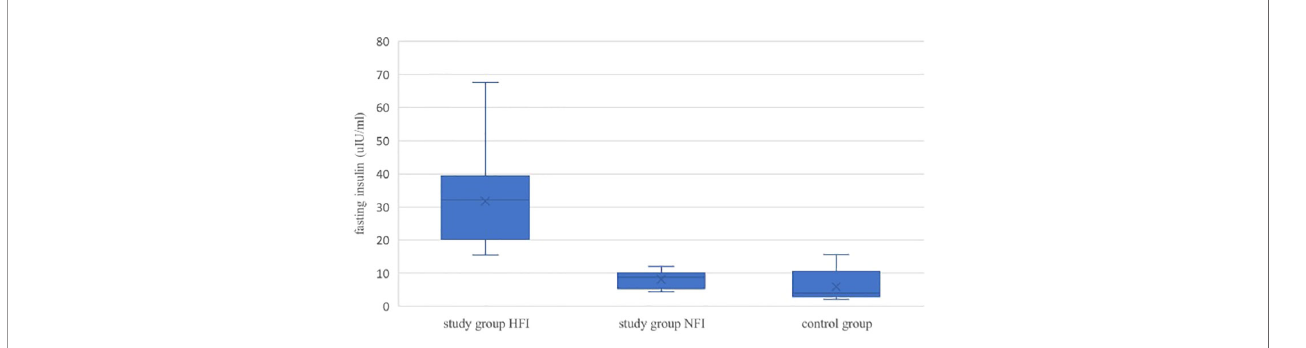
FIGURE 4 | Comparison of fasting insulin concentration in overweight/obese children and controls. Study group HFI v study group NFI p < 0.001, study group HFI v control group p < 0.001, study group NFI v control group p = 0.11. HFI- high fasting insulin, NFI- normal fasting insulin. All box plots represent the minimum, the fi rst quartile, the median, the mean, the third quartile and the maximum. A p < 0.05 was considered signi